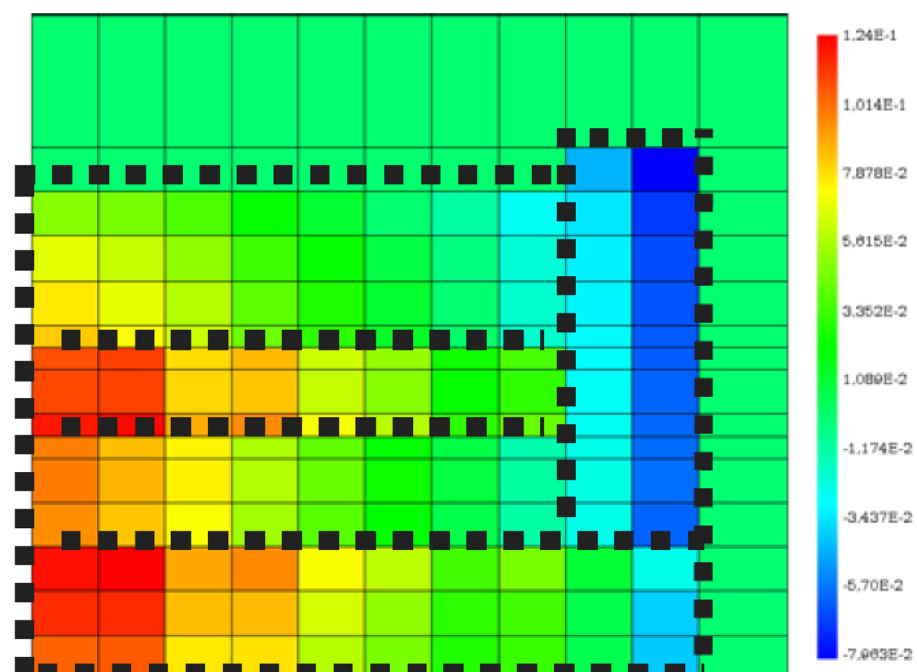
Fig. 8. ASTRID reactor (cid:1) Fissile +fertile partition into 132 regions (cid:1) Sensitivity of the fi ssion source distribution to the 239 Pu fi ssion